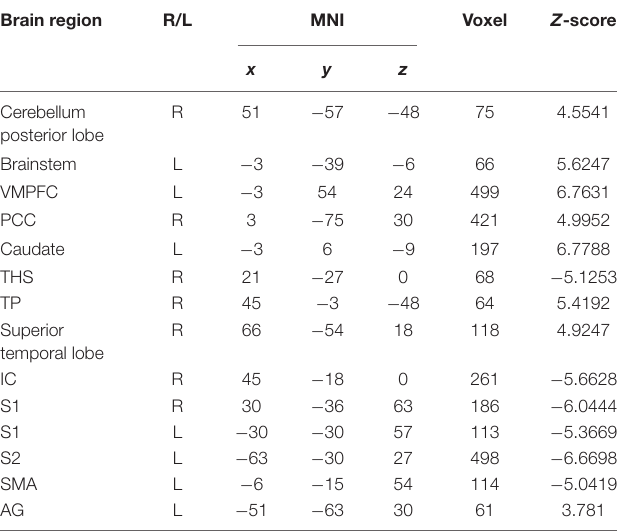
TABLE 4 | Summary of the brain areas showing functional connectivity with the rACC in comparison of male participants and female participants in placebo response ( p < 0.05, FDR < 0.05).